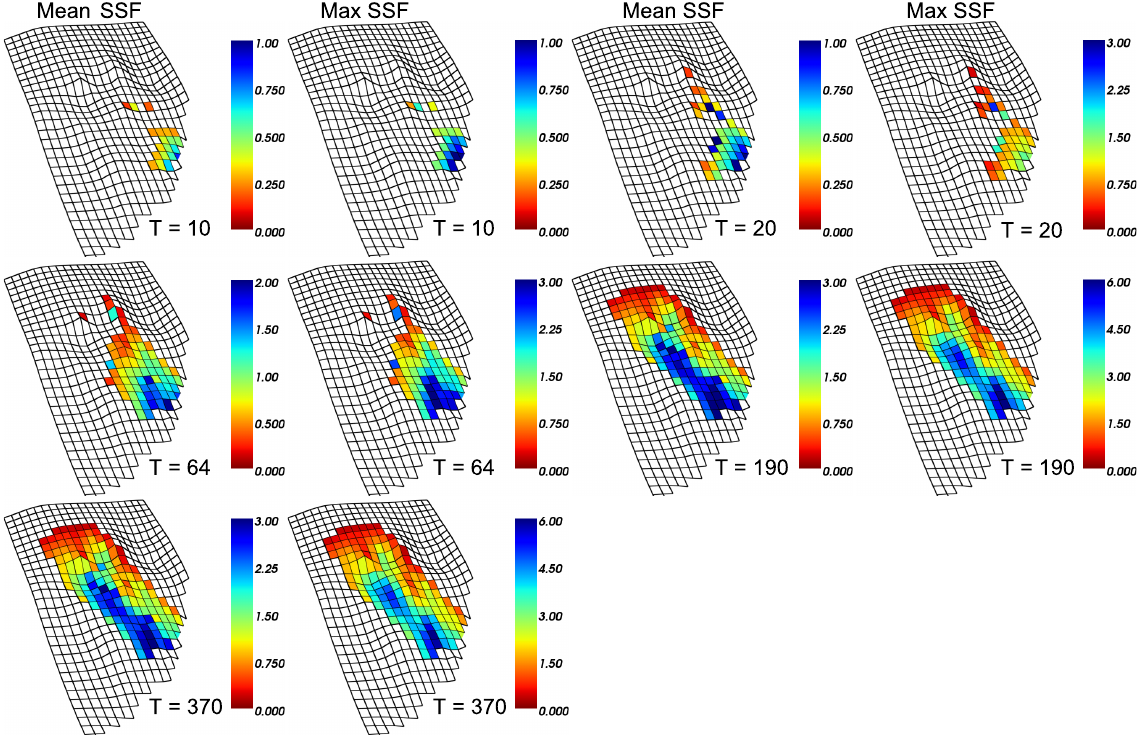
Figure 11. Simulated ratios of average subsurface flow and recharge fluxes (mean SSF), and simulated ratios of maximum subsurface flow and recharge fluxes (max SSF) by Model 2 with the best parameter set. Time ( T )is indicated as hours since the application of labeled sprinkler